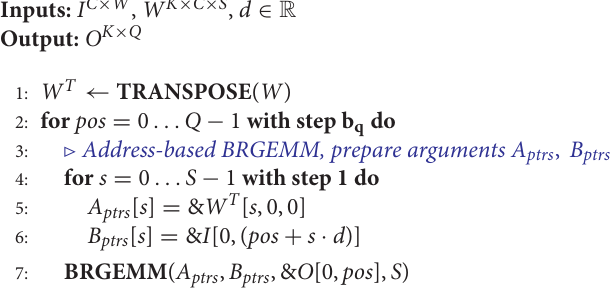
Algorithm 7 | 1D Dilated convolution forward pass using TPPs.